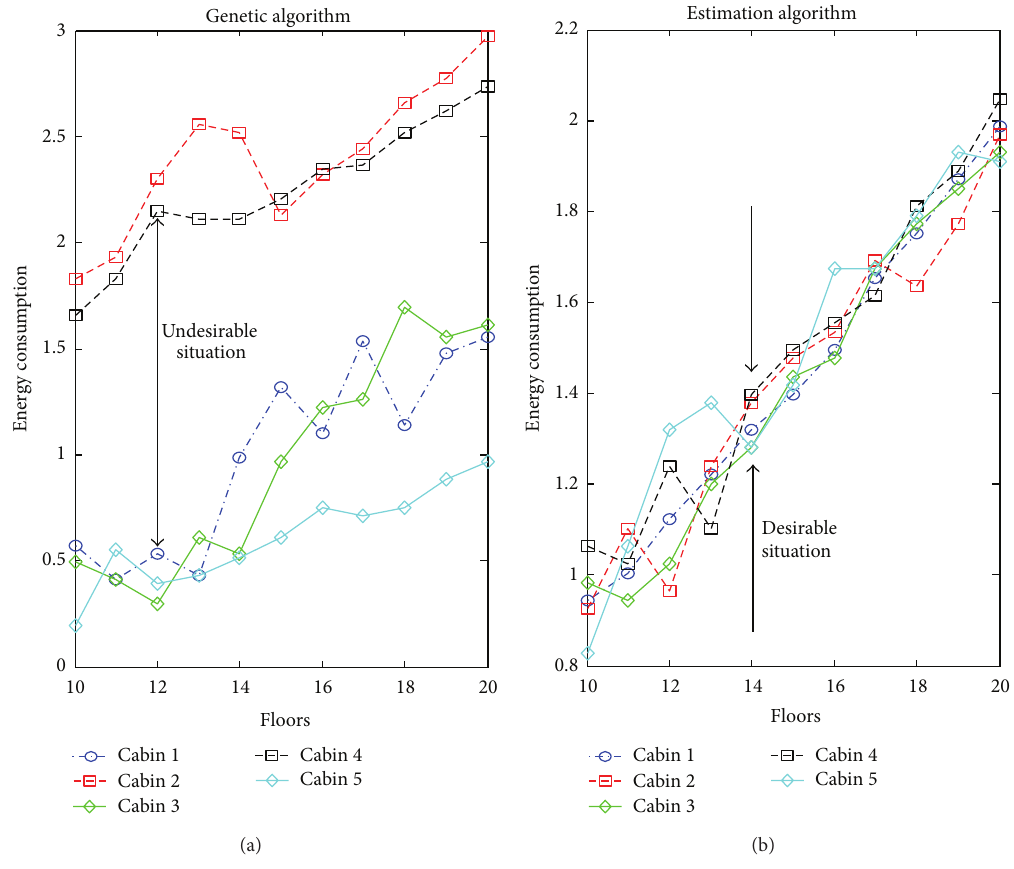
Figure 10: Energy consumption of cabins according to floors. Table 4: Average waiting time of passengers